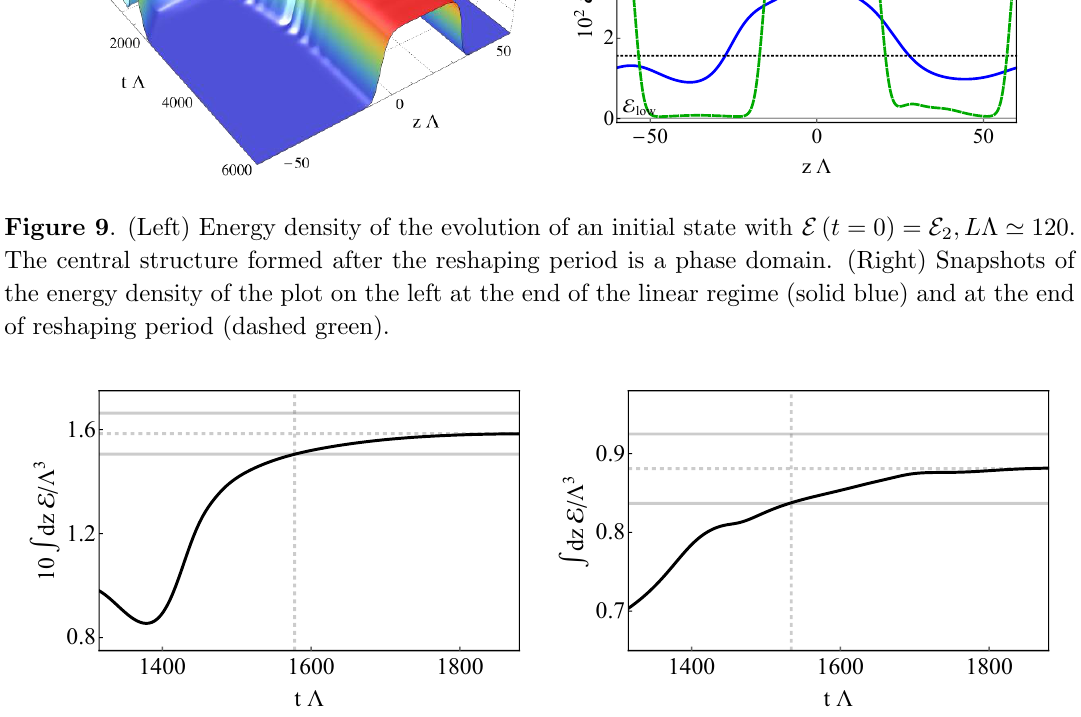
Figure 10 . Time evolution of the energy density contained in the peak (left) and the domain (right) of (cid:12)gure 9 starting at the end of the linear regime. The dashed horizontal lines are the values that these integrated energy densities tend to, and the continuous horizontal lines indicate a 5% band around them. The vertical lines at t (cid:3) = 1578 (left) and t (cid:3) = 1534 (right) show the times at which the corresponding curves enter these bands. The end of the reshaping period is given by the largest of these